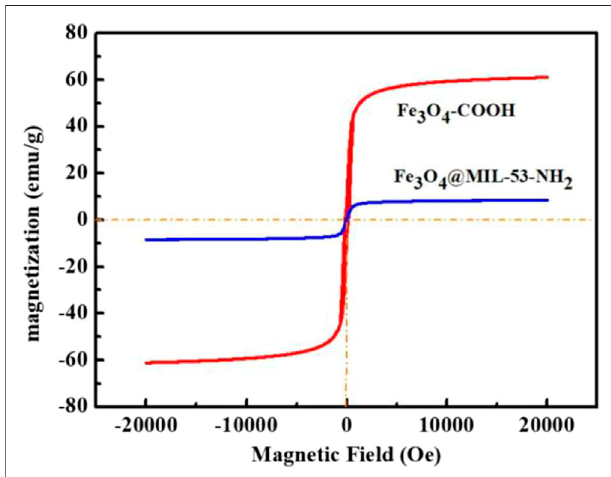
FIGURE3| VibratingsamplemagnetometryimageofFe 3 O 4 -COOHand Fe 3 O 4 @MIL-53(Al)-NH 2 .